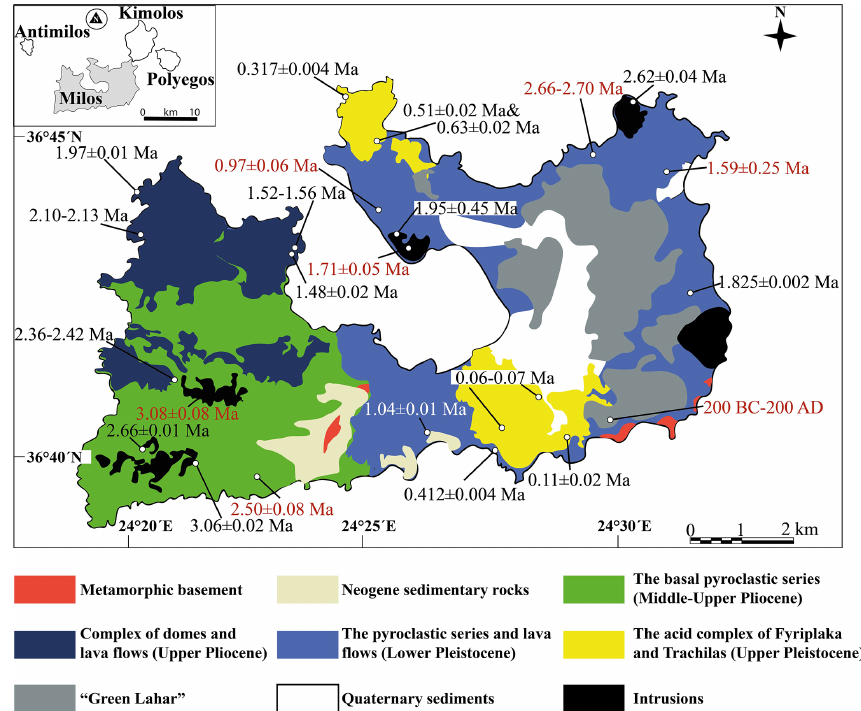
Figure 3. Simplified geological map of Milos with 40 Ar / 39 Ar ages of this study and sample locations of key volcanic deposits, modified after Stewart and McPhie (2006) and Grasemann et al. (2018). The stratigraphic units of Milos are from Fytikas et al. (1986). Age data from this study are in black; published ages are shown in red (Angelier et al., 1977; Fytikas et al., 1986; Traineau and Dalabakis, 1989; Stewart and McPhie, 2006). The “green lahar” (Fytikas, 1977) consists of deposits from multiple phreatic explosions and contains fragments of metamorphic, sedimentary and volcanic